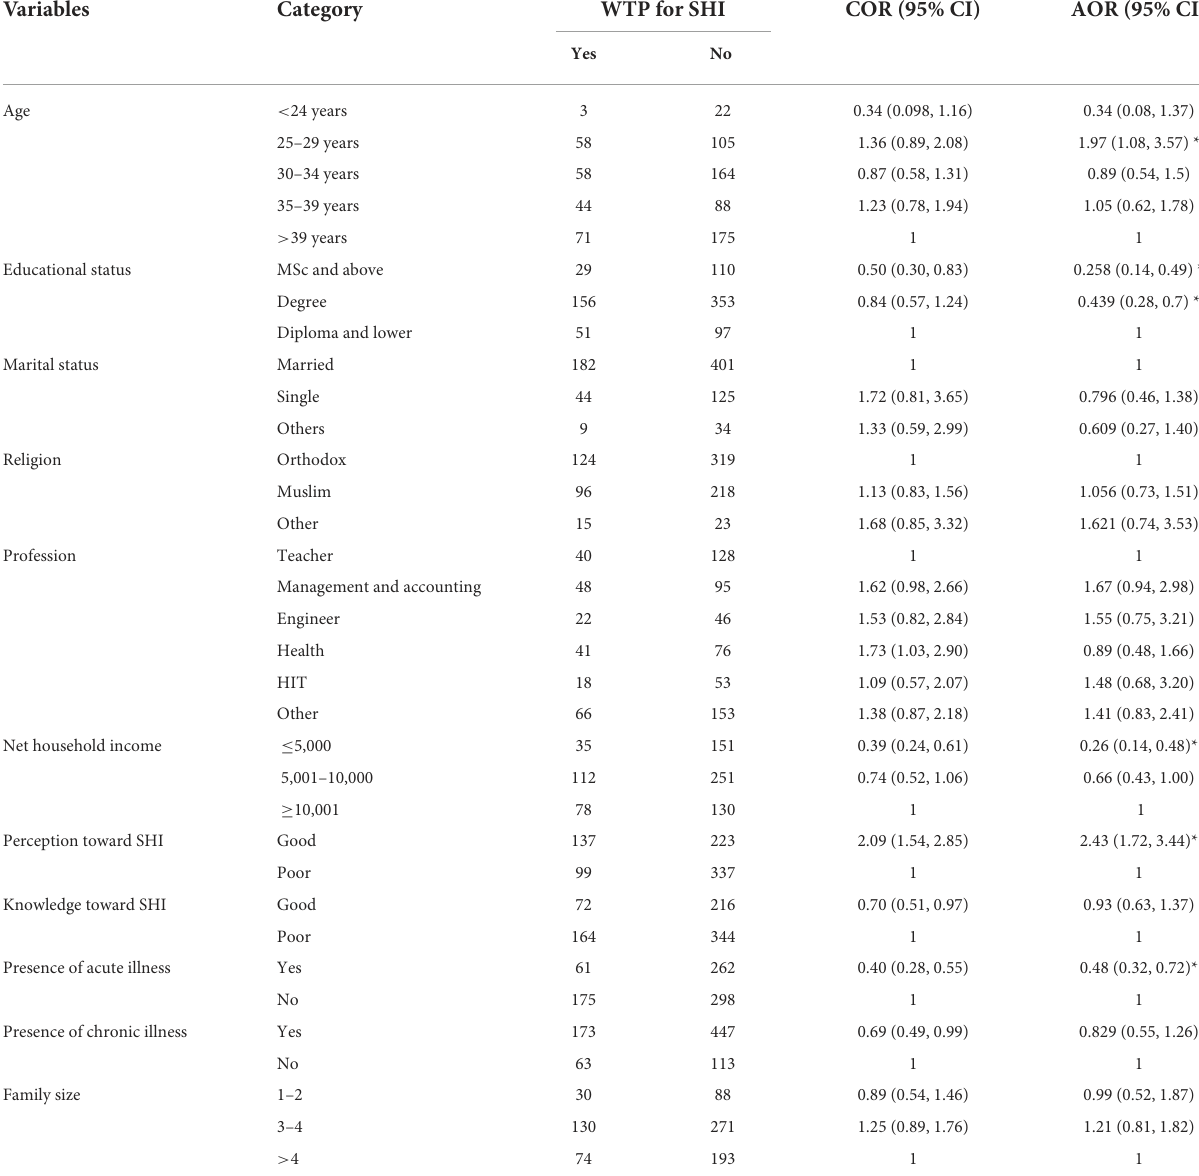
TABLE 6 Bi-variable and multi-variable logistic regression for WTP for SHI among public civil servants in DCA, North-East Ethiopia ( n = 796), May 2021.